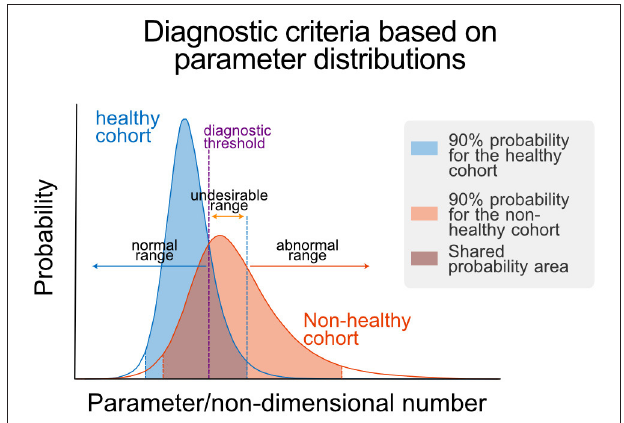
FIGURE 3 | Parametric definition of health. Schematic representation of the determination of normal, undesirable, and abnormal ranges for a given parameter/NDN. These ranges are defined using the parameter/NDN distributions of the healthy and non-healthy cohorts, using the central 90% confidence interval of the healthy cohort distribution as limit of the non-healthy range and the point of equal probability density as the threshold between normal and undesirable ranges. Threshold values are reported in Table 1